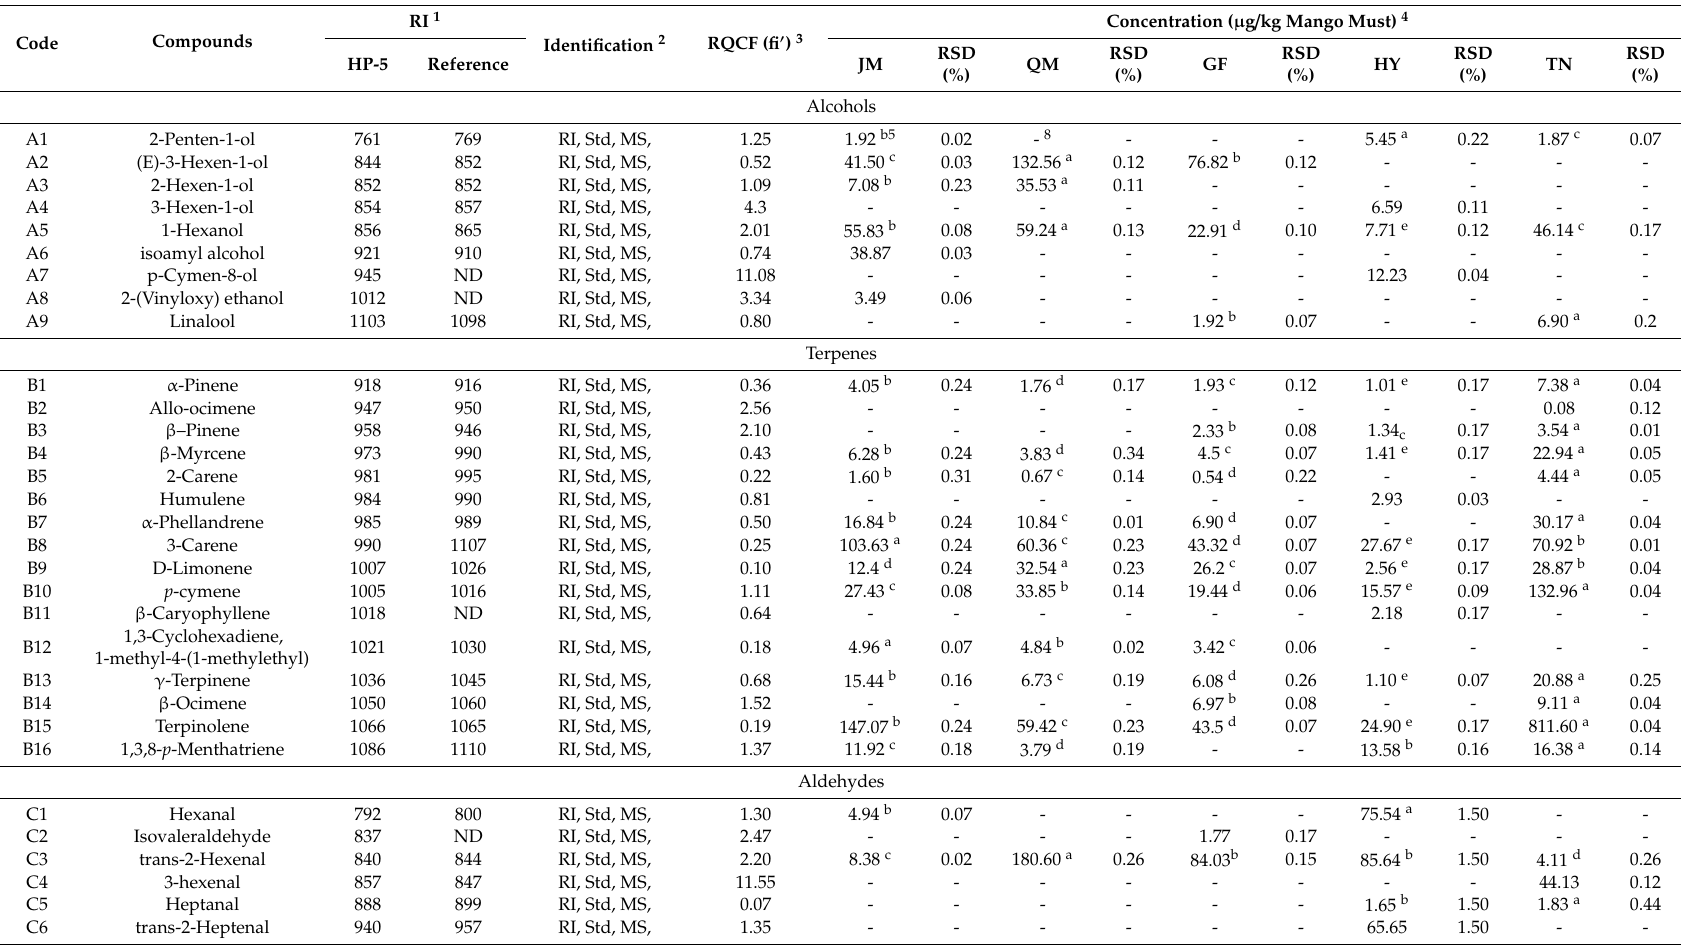
Table 1. Volatile compounds identified in five di ff erent cultivars of Chinese mango samples using SPME-GC /